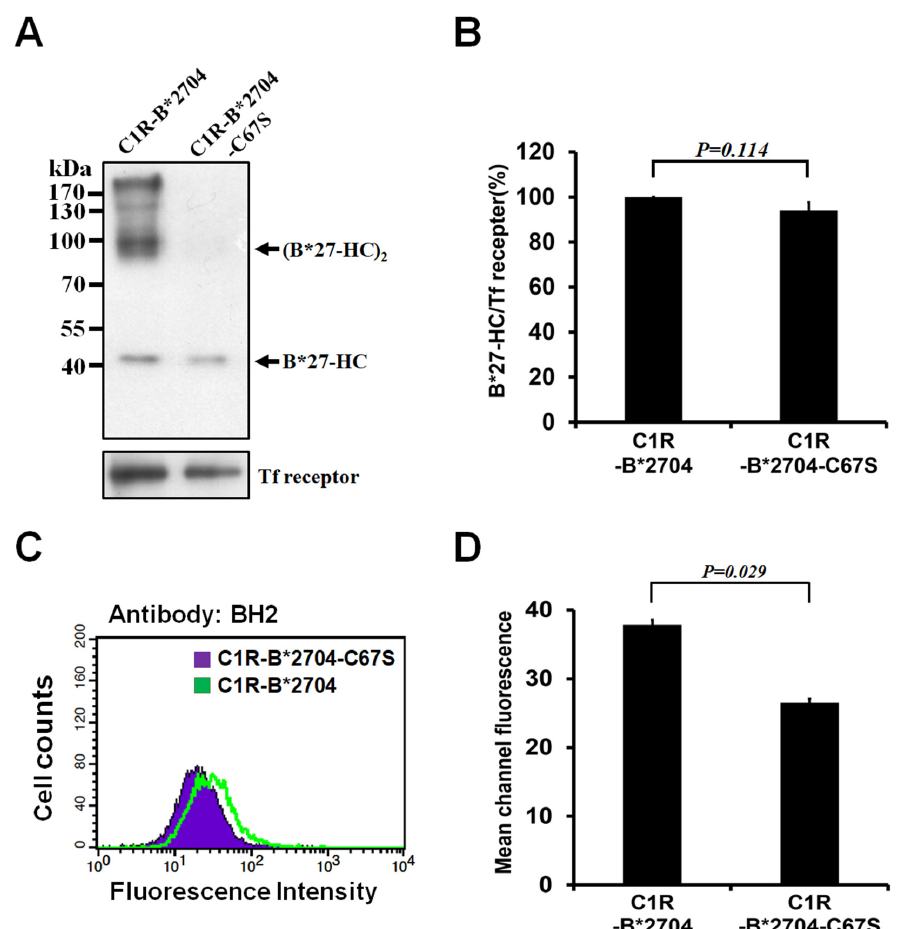
Figure 1. Analyses of membrane-bound B*27-HC species of C1R-B*2704 or C1R-B*2704 C67S cells through Western blotting and flow cytometry. The membrane-bound proteins of C1R-B*2704 or C1R-B2704 C67S cells were labeled with biotin and isolated by pull-down using avidin beads. ( A ) Analysis of membrane-bound B*27-HC species via Western blotting. An aliquot (50 µ g) of each protein extract was separated using non-reducing SDS-PAGE, followed by Western blotting using the BH2 monoclonal antibody. ( B ) The ratio of monomeric B*27-HC/transferrin receptor obtained from Figure 1A is plotted. Values (mean ± SD, n = 4) are averaged from four independent experiments. ( C ) The membrane-bound HLA-B*2704 C67S or HLA-B*2704 was pre-associated with BH2, stained with FITC-conjugated secondary antibody, and analyzed via flow cytometry. ( D ) The results